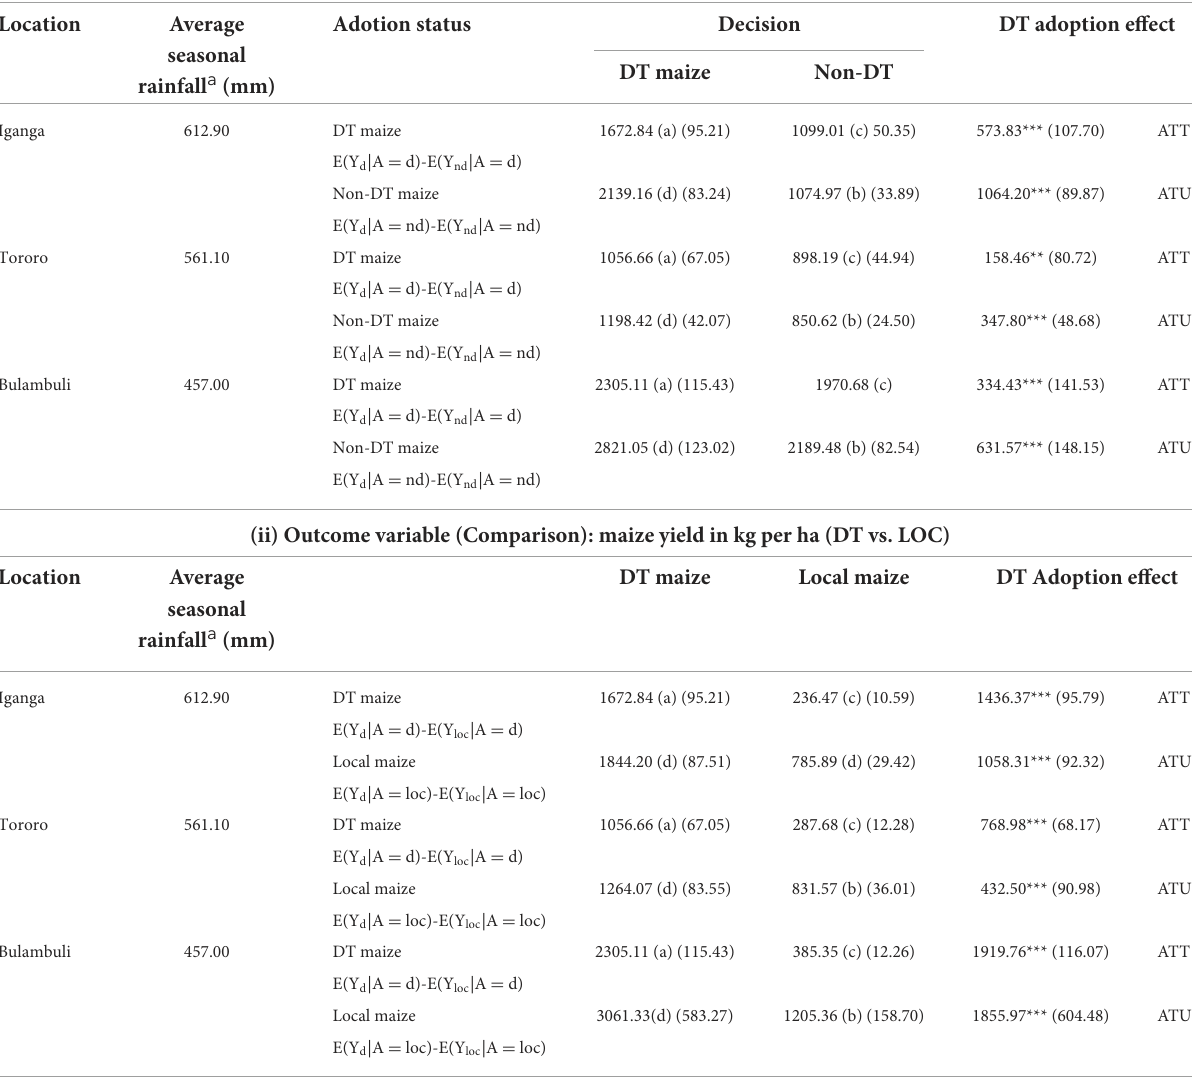
TABLE 5 Average effect of DT adoption by districts. (i) Outcome variable (Comparison): Maize yield in kg per ha (DT vs. NDT)